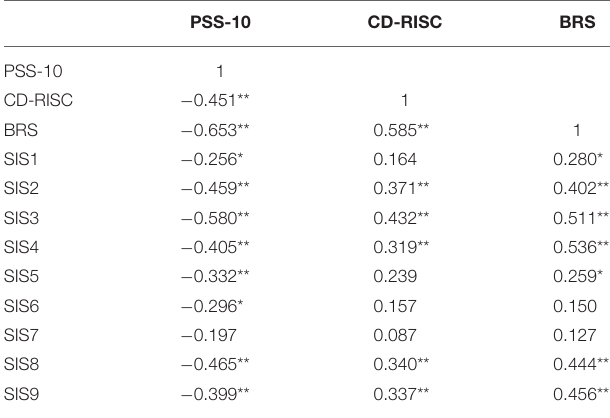
TABLE 3 | Pearson correlations between stress, resilience, and stroke outcome measures (stroke